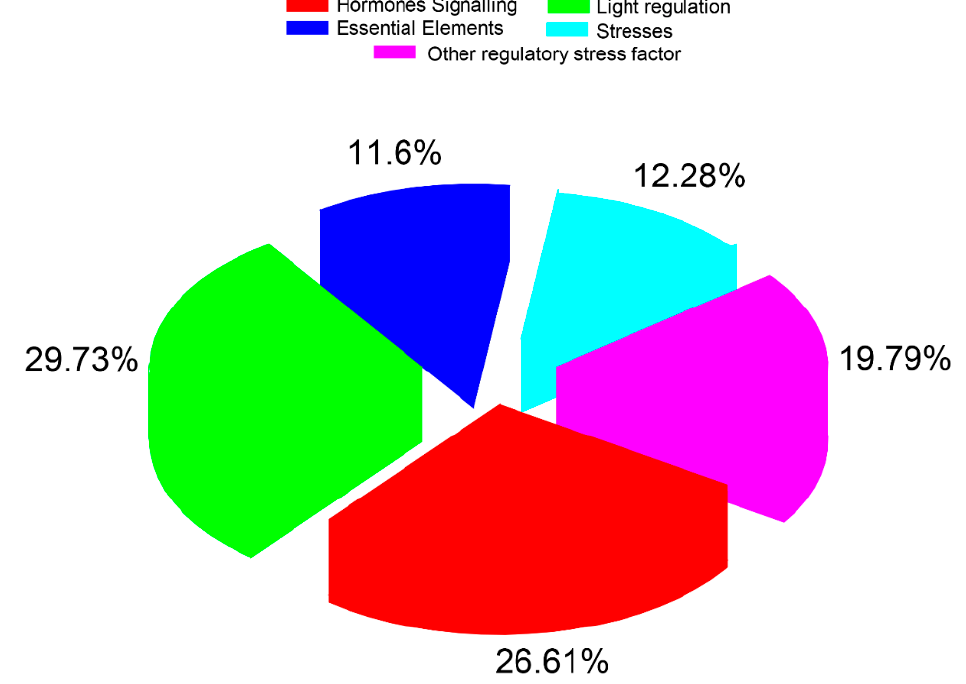
Figure 5. Various cis elements found in cucumber using the PlantCARE database.